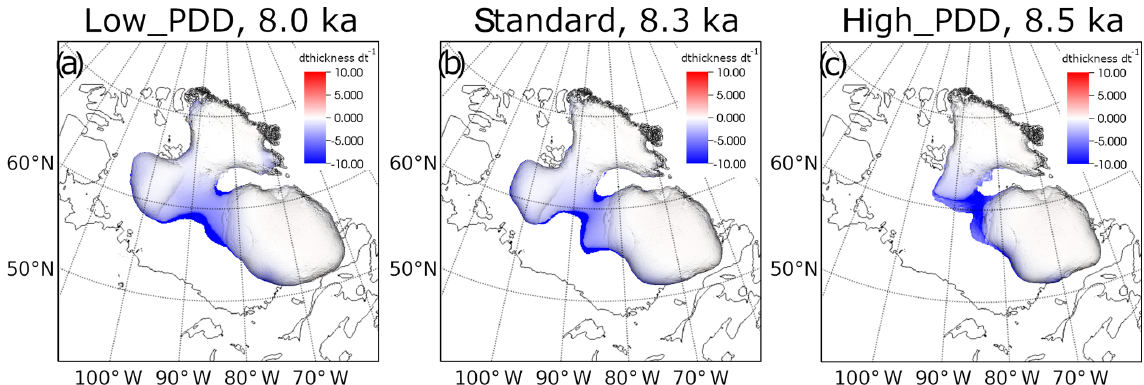
Figure 9. Laurentide Ice Sheet at the approximate time of the peak freshwater flux in the (a) low_PDD simulation, (b) standard simulation, (c) high_PDD simulation. The separation of the Keewatin and Labrador domes in the standard and high_PDD simulations is at a more advanced stage at the time of peak freshwater flux compared to the low_PDD simulation. The freshwater flux in low_PDD would likely have increased as the separation of the ice domes would have continued if the simulation was run for longer than 2000